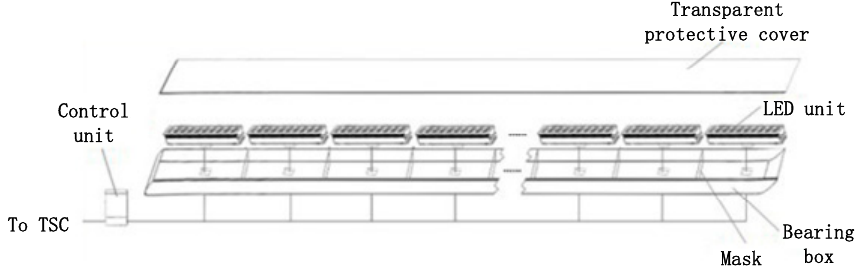
Figure 12. Schematic diagram of variable lane line structure.